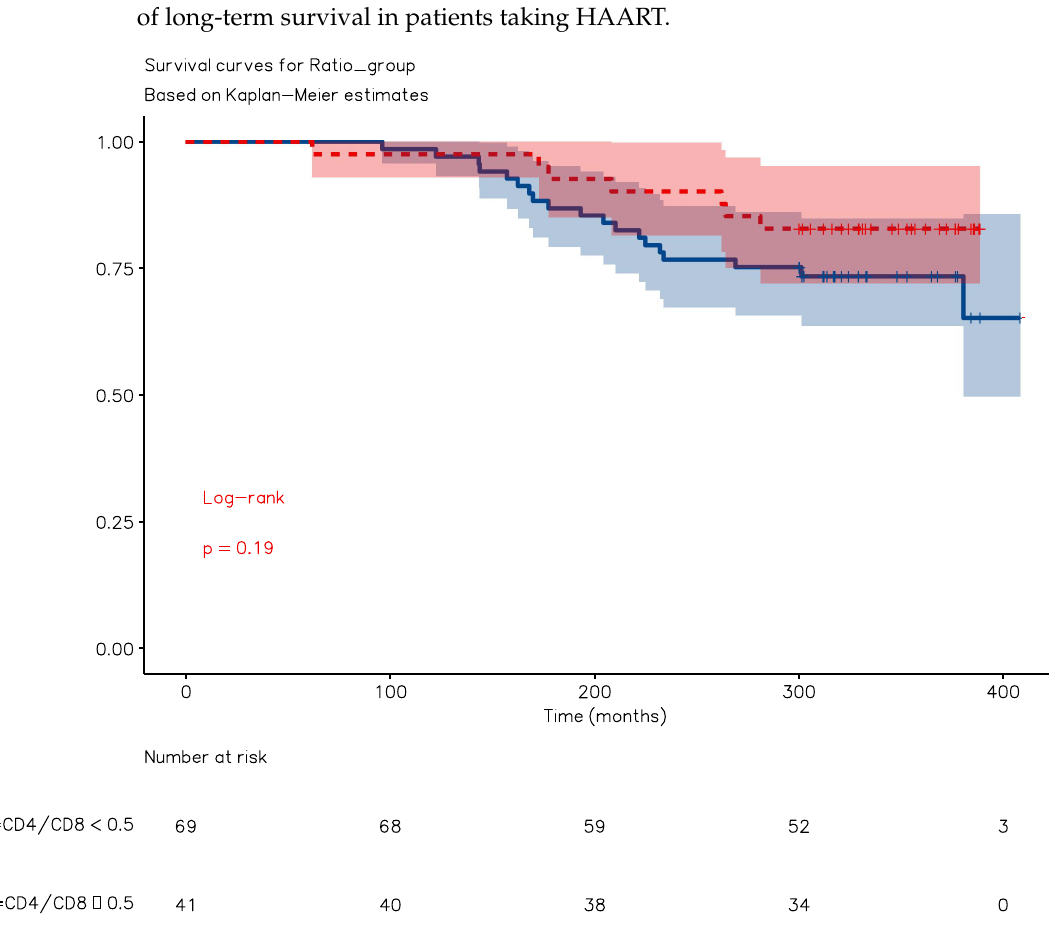
Figure 6. CD4+/CD8+ ratio at diagnosis is not a good predictor of survival. This figure shows that there is no statistically significant difference in terms of survival between those who were diagnosed with a CD4+/CD8+ ratio lower than 0.5 (blue) and those who received their diagnosis when the CD4+/CD8+ ratio was higher than 0.5 (red). All the PLWH included in this analysis received HAART. We also evaluated the effect on survival time of antiretroviral treatment before HAART ( p = 0.59), of having HCV co-infection ( p = 0.27), and of having HBV co-infection ( p = 0.84). Although having AIDS at diagnosis was a statistically significant predictor of mortality in the whole cohort, this significance was not confirmed when only PLWH having access to HAART were considered ( p = 0.79).